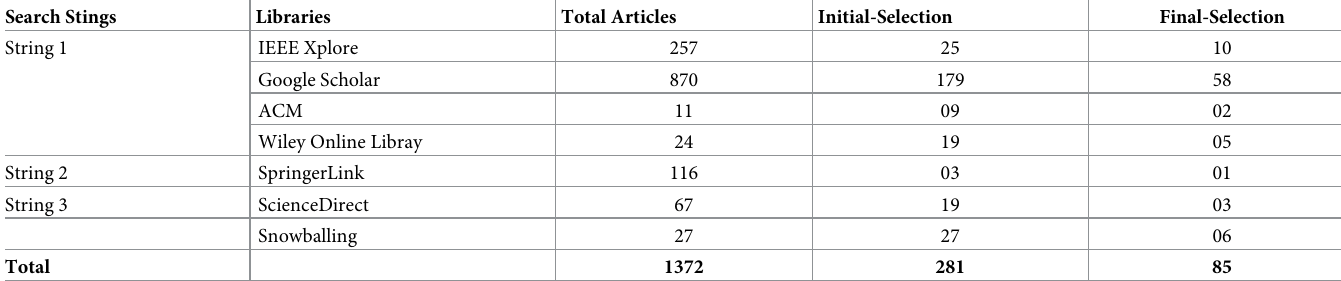
Table 1. Search strings outcomes